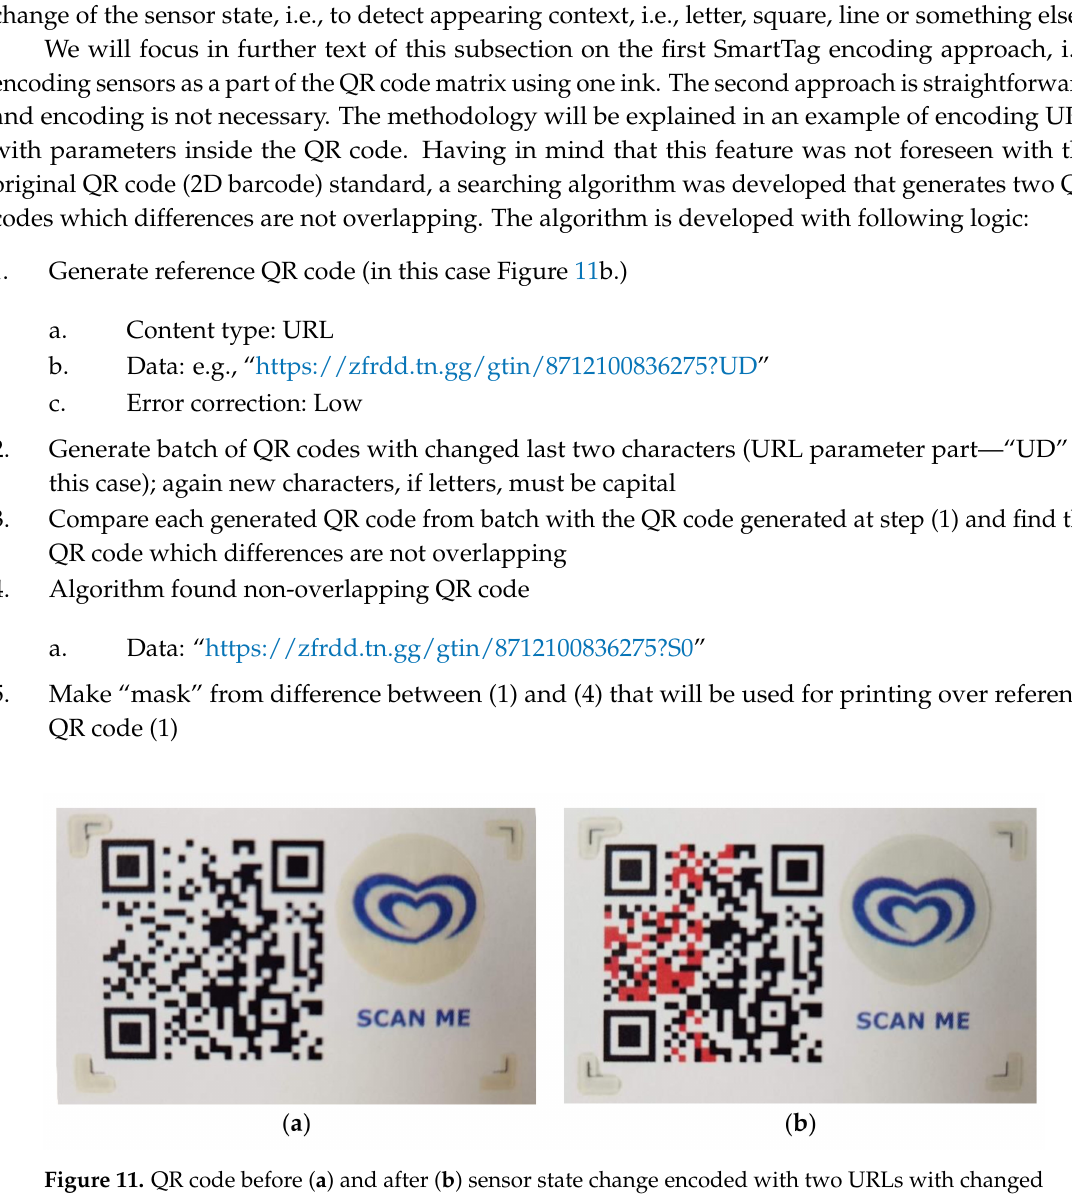
Figure 11. QR code before ( a ) and after ( b ) sensor state change encoded with two URLs with changed last two